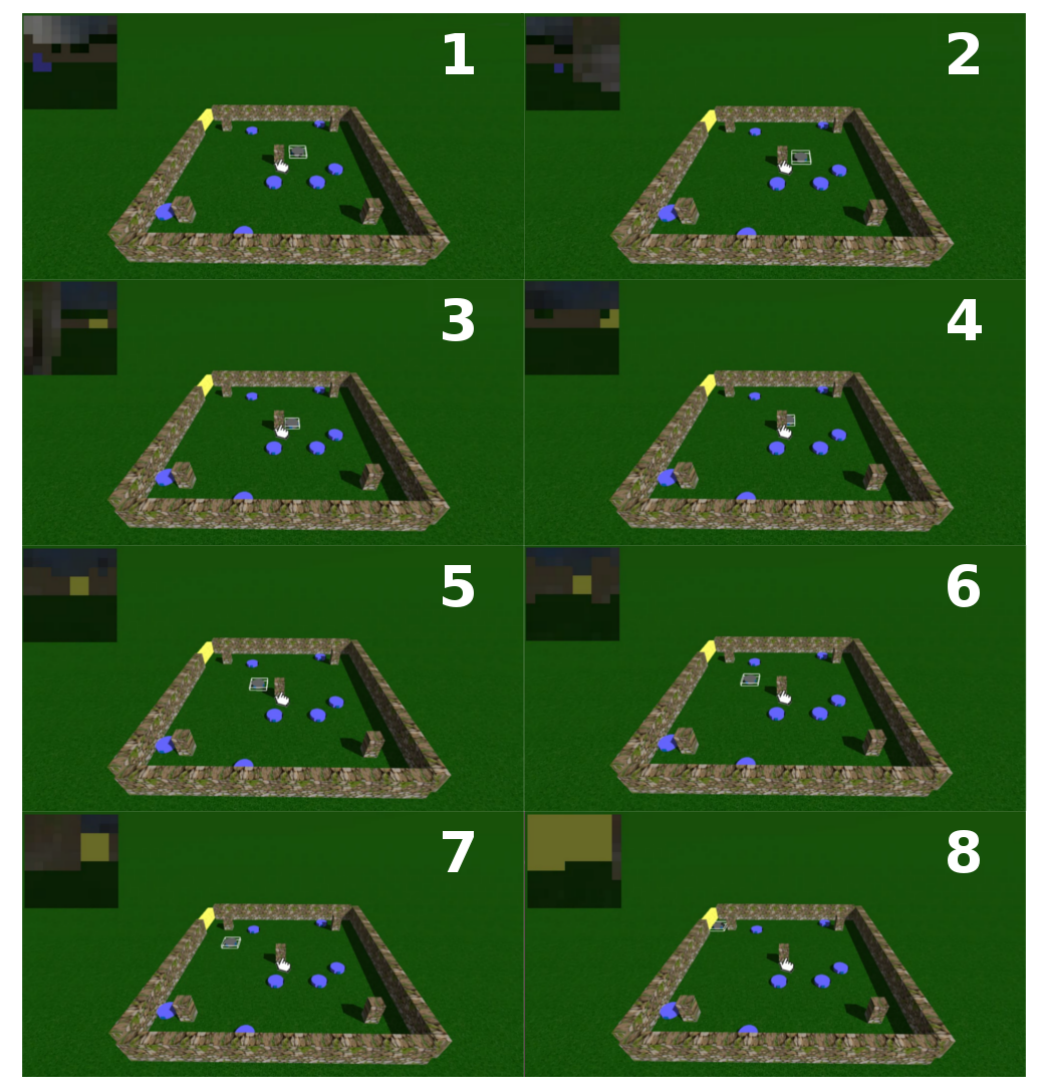
Fig. 9. Agent’s behavior when a new situation is presented to it. The agent reaches the door successfully avoiding the